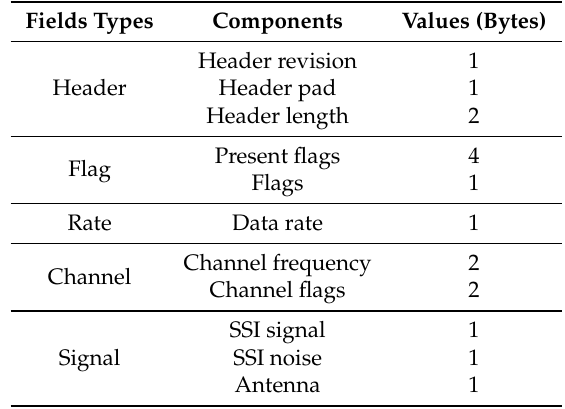
Table 3. RadioType header subframe format.